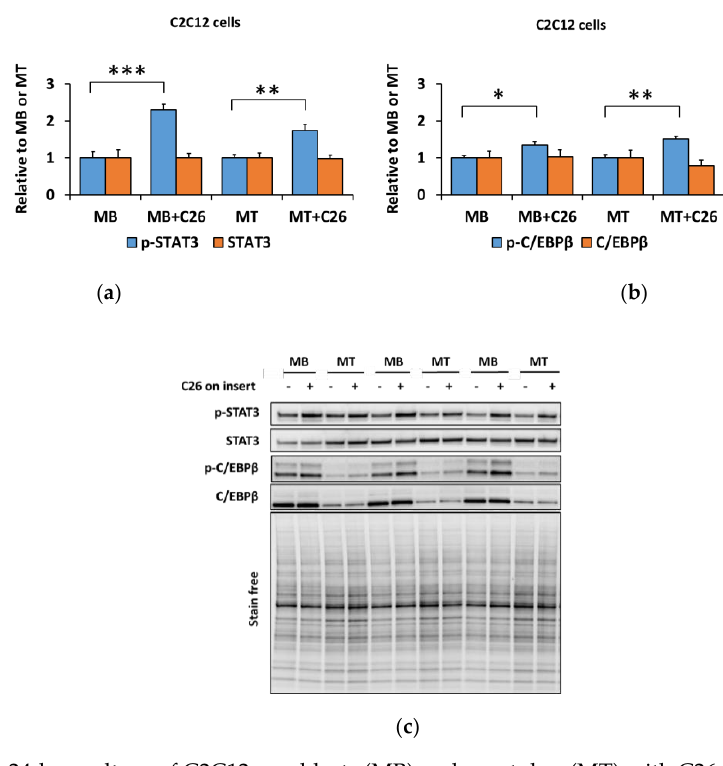
Figure 4. The 24-h coculture of C2C12 myoblasts (MB) and myotubes (MT) with C26 cells promotes inflammatory response independent of the differentiation stage. ( a ) Phosphorylated STAT3 Tyr705 and total STAT3. ( b ) Phosphorylated C/EBPβ Thr235 and total C/EBPβ. ( c ) Representative blots. In the figures, MB or MT with empty insert (-) are set as one and compared with MB or MT with C26 cells on the insert (( + ), MB + C26 and MT + C26, respectively). N = 6–8 per group. *, **, and *** = p < 0.05, p < 0.01, and p < 0.01,